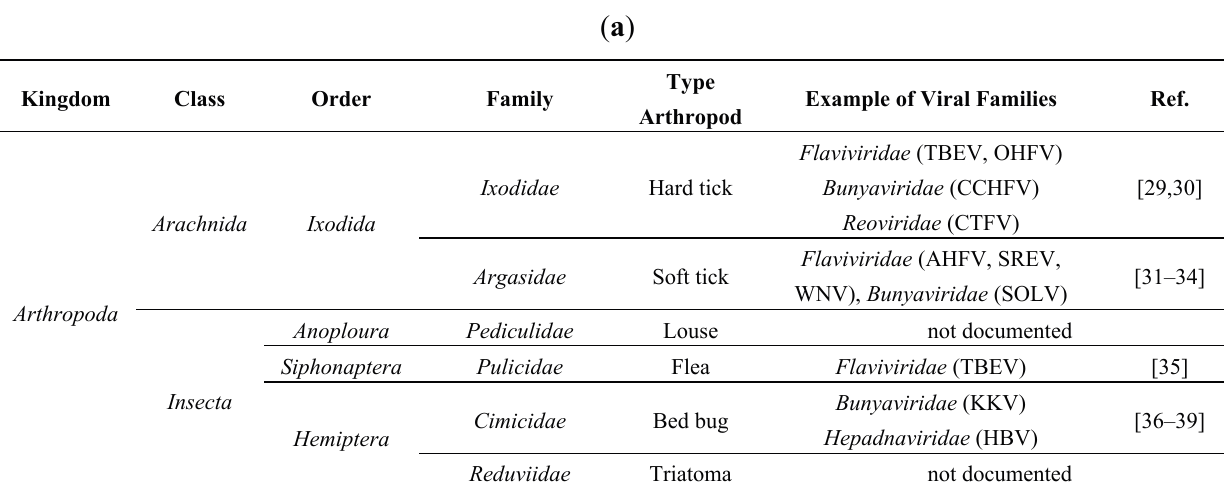
Table 1. ( a ) Non-exhaustive list of major viruses detected in blood-feeding arthropods by various serological or molecular techniques; ( b ) Examples of viruses detected in mosquitoes by metagenomic